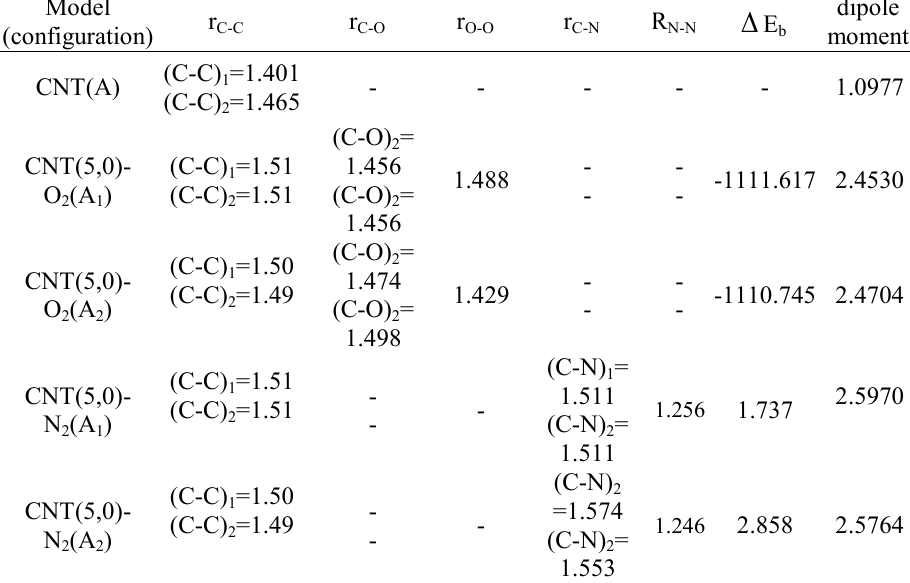
the (5, 0) SWCNT a .